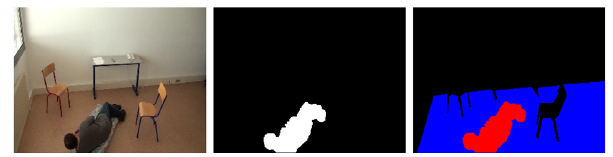
Fig. 11 A fallen person lies on the floor. Blue region: detected floor. Red region: intersection of the foreground human body with the